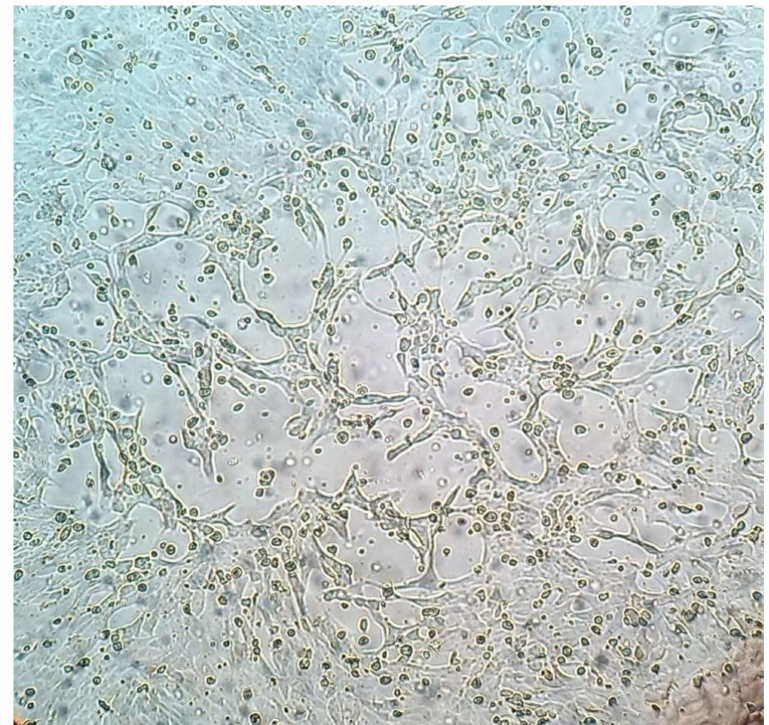
Figure 1. Madin–Darby bovine kidney (MDBK) cells infected with ChamoisRV / IT2014 strain showing lytic cytopathic e ff ect (CPE) at 72 h post infection.